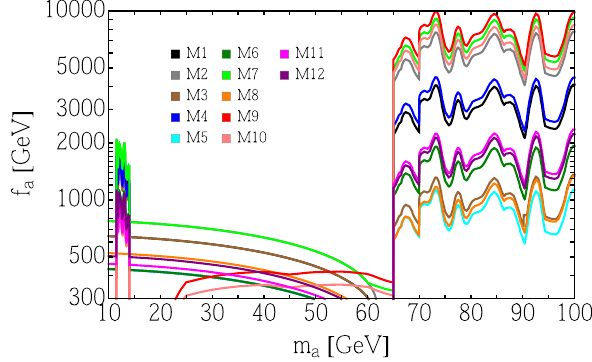
Fig. 1 Constraintson f a asafunctionof m a forthebenchmarkmodels M1 - M12, defined in Table 1. The bounds arise from di-muon searches [22,23] in the low mass range, di-photon searches [3,4] in the higher one, and from the BSM decay width of the Higgs [24] below 65 GeV. We have also indicated the current bounds obtained by adapting the results in [10] in the region between 20 and 65 GeV for the two models (M9 and M10) where they are the